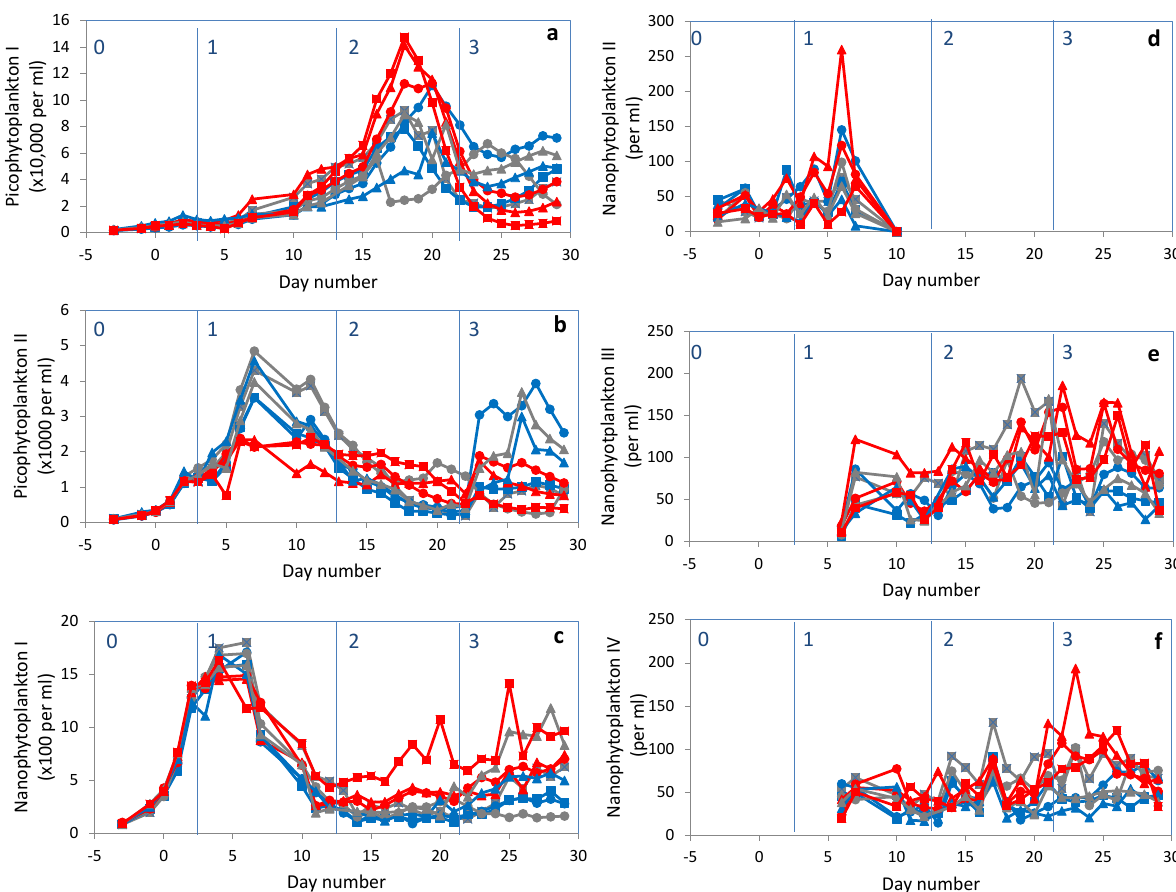
Fig. 1. Temporal dynamics of depth-integrated (0.3–12m) picophytoplankton cluster I (a) , picophytoplankton cluster II (b) , nanophytoplank- ton I (c) , nanophytoplankton II (d) , nanophytoplankton III (e) and nanophytoplankton IV (f) . Only eukaryotic photosynthetic organisms were detected. Low CO 2 treatments are blue, intermediate CO 2 treatments are grey, and high CO 2 treatments are red colored. In order of low, intermediate and high p CO 2 mesocosms, the circles represent mesocosms M3, M4 and M6; triangles M7, M8 and M5; and squares M2, M1 and M9,